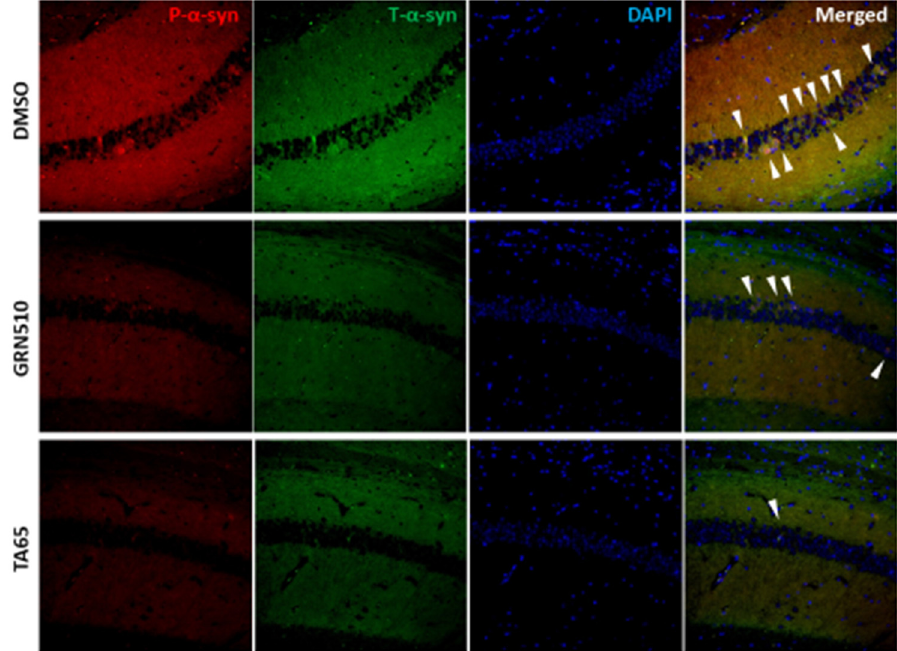
Figure 1. Phosphorylated (red signal) and total (green signal) α -synuclein in the CA1 region of the hippocampus of DMSO-treated (control), GRN510 and TA-65 treated mice. White arrowheads show merged signals of phosphorylated and total α -synuclein. Blue signals are DAPI for nuclear staining. For details and quantification, see [67].